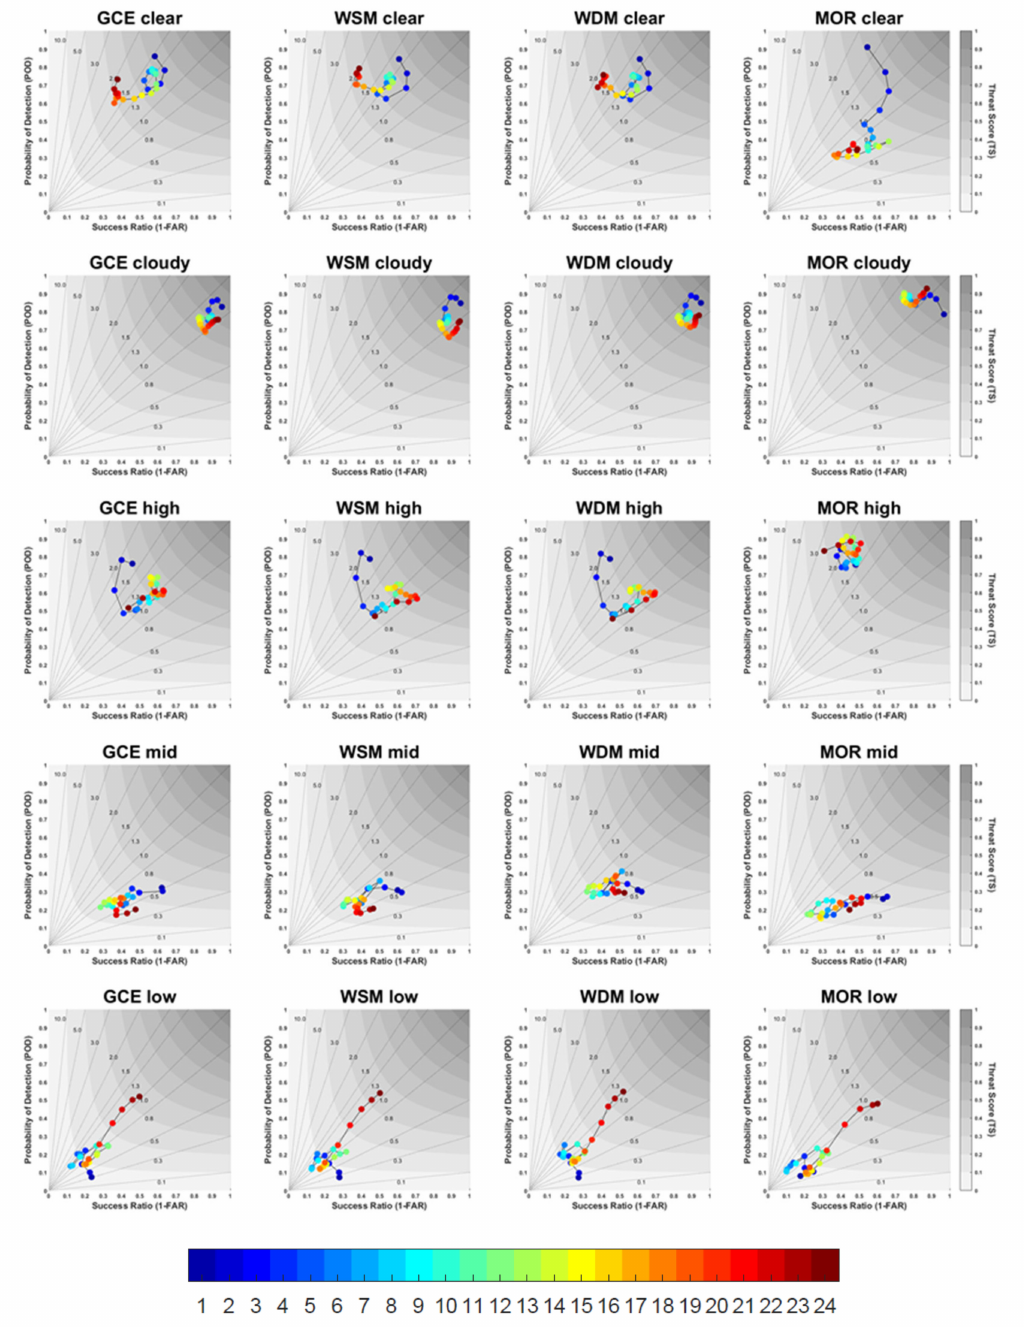
Figure 13. Performance diagram of 24-h simulation. The color of dots indicates the simulation time steps starting from 1 June 2017 at 1300 UTC to 2 June 2017 at 1200 UTC at 1-h intervals. Each row illustrates the performance of di ff erent cloud top types and each column indicates the simulation using each MP